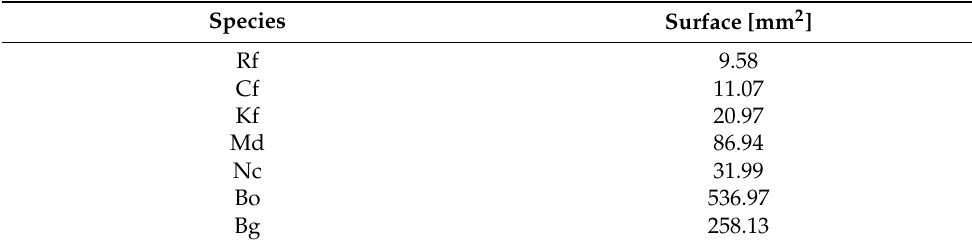
Figure 3. ( A ) Total extracted CHC amount (assessed and quantified by GC-MS) per individuum of our seven tested Blattodea species in ng. ( B ) Proportional CHC amount per individual in ng per mm 2 body surface area. Means and standard deviations are given, statistical comparisons have been performed with Hommel corrected Mann-Witney U tests, significant differences are indicated by different letters. Species abbreviations and insect images are depicted as in Figure 2. Table 1. Body surface area measurements in mm 2 based on one representative DISC 3D scan for each of the seven tested Blattodea species. Species abbreviations as in Figure 2, interactive 3D images of each tested species are accessible in Figure S3.